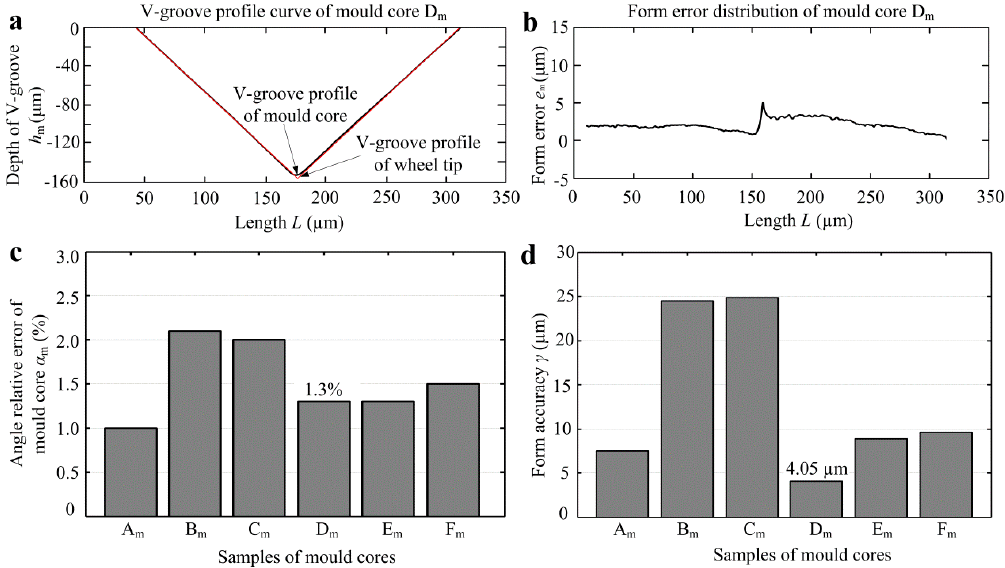
Figure 9. The angle relative error α m and form accuracy γ of mold core: (a) V-groove profile curves of wheel tip and mold core D m ; (b) form error distribution of mold core D m ; (c) angle relative error α m ; (d) form accuracy γ .